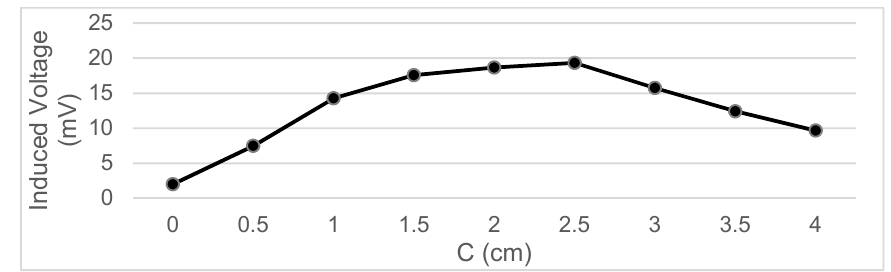
Figure 11. Data representation for B = 15 cm, A = 18 cm; Test 4.6.